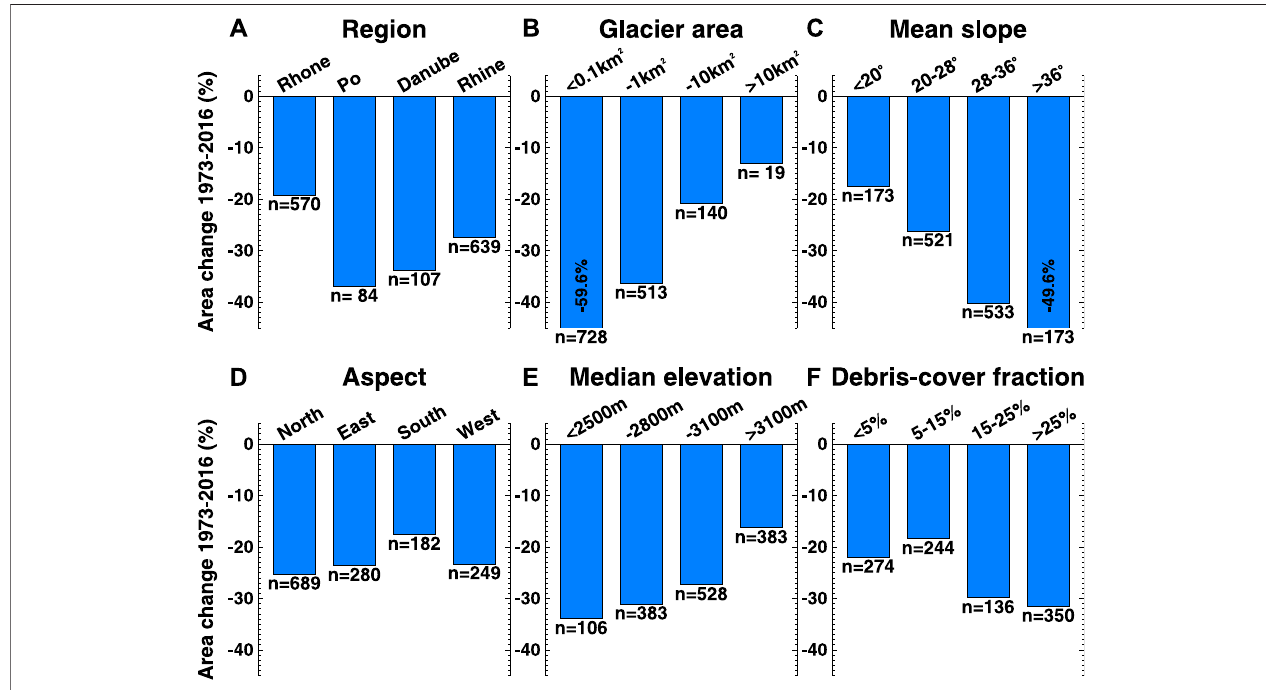
FIGURE 10 | Arithmetic mean of glacier-speci fi c relative area changes 1973 – 2016 according to (A) the major catchment, and classes of (B) glacier area, (C) mean surfaceslope, (D) principal surface aspect, (E) median elevation, and (F) debris-cover fraction according totheSGI2016. The number ofglaciersper class ( n ) is